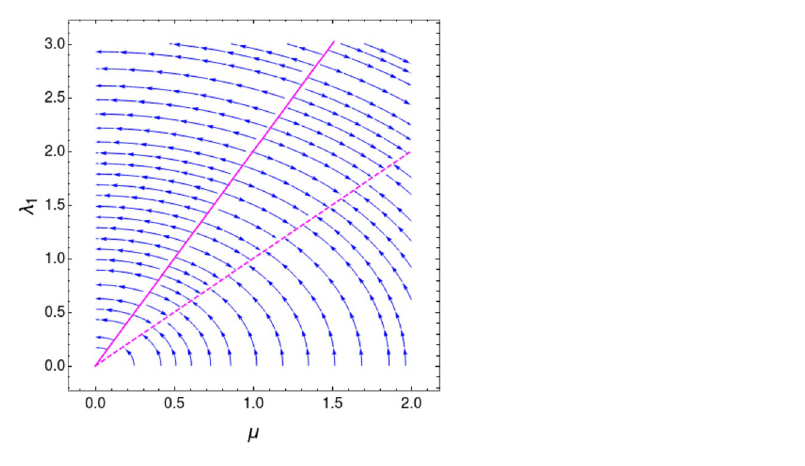
(cid:31) 2 µ (solid line) 1 =